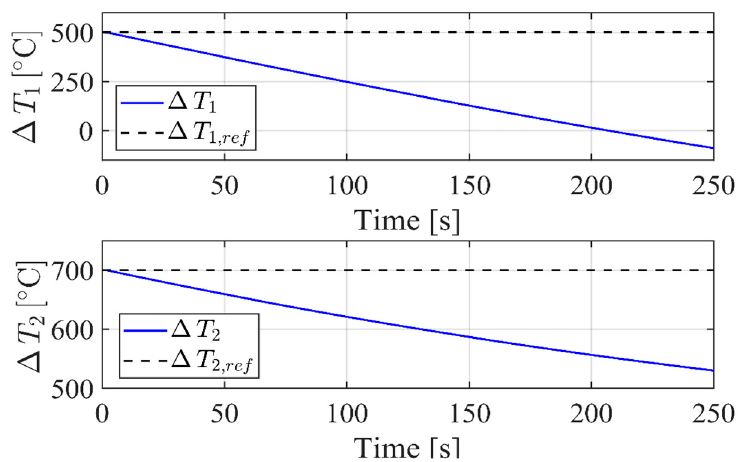
Figure 9. Unstable behavior of the system due to large uncertainties.